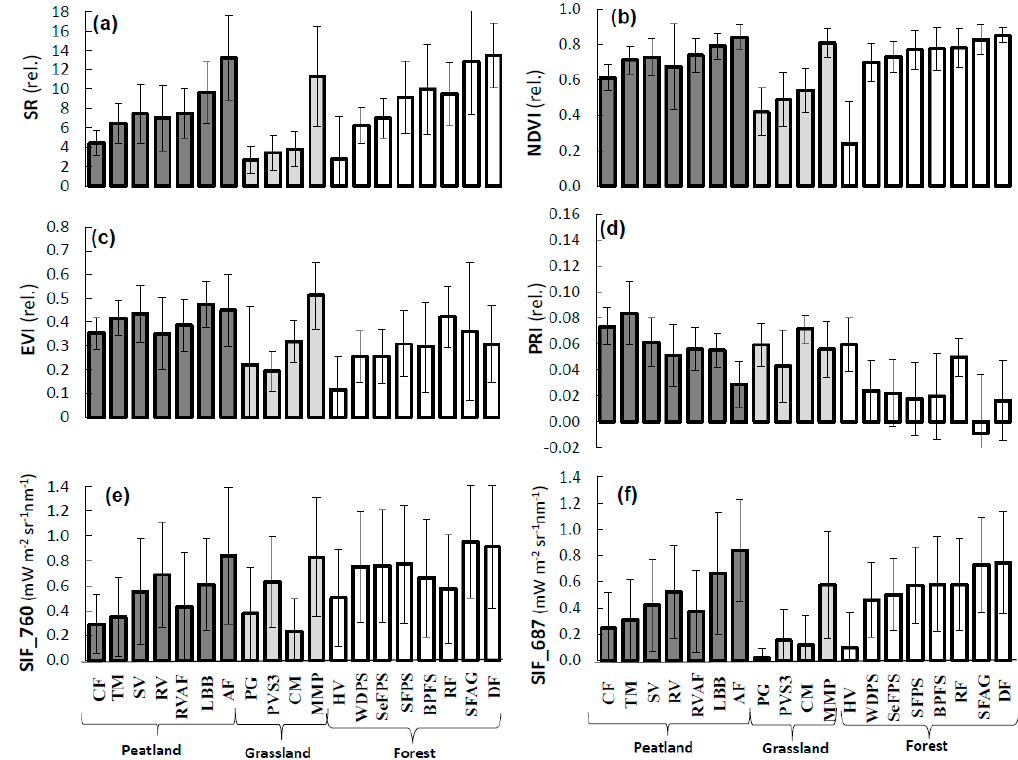
Figure 7. Bar diagram presenting the average values of the observed VIs and SIF derived from HyPlant data; ( a ) SR, ( b ) NDVI, ( c ) EVI, ( d ) PRI, ( e ) SIF 760 , and ( f ) SIF 687 . The names of the individual vegetation groups are written at the bottom of the bars and correspond to the abbreviations provided for Figure 3a. The dark grey group of bars represents the peatland ecosystem; light grey bars represent di ff erent kinds of grasslands (including the post-agricultural land, pioneer vegetation of sandy and shallow soil); and white grey bars stand for di ff erent kinds of forests. Error bars represent standard deviation.